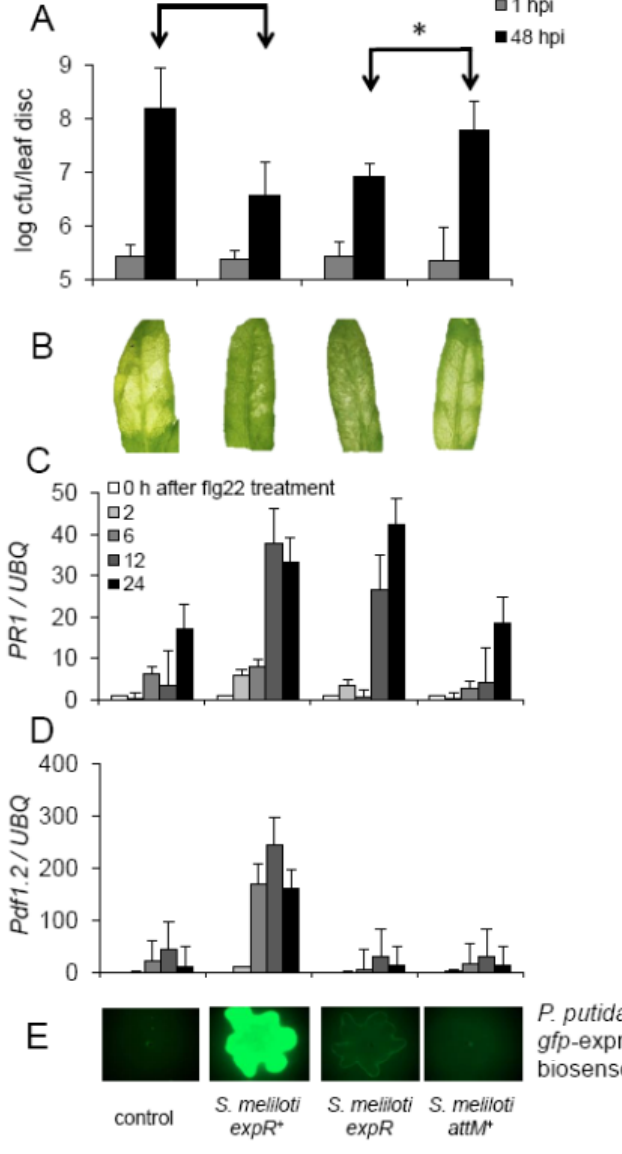
Figure 4. The S. meliloti strains producing oxo-C14-HSL enhance resistance in Arabidopsis plants. The enhancement in resistance towards the pathogenic bacteria in Arabidopsis is dependent on AHL. ( A ) Proliferation of the plant-pathogenic P. syringae DC3000 ( Pst ) on plants pretreated with MgCl (control) or different S. meliloti strains, 2 producing different quantities of oxo-C14-HSL. *** p > 0.0005; * p > 0.05 in Student’s t -test. cfu; colony forming unit ( B ) Symptoms caused by infiltration with Pst bacteria into Arabidopsis leaves; ( C ) and ( D ) Expression of the defense related Pathogenicity Related 1 ( PR1 ) ( C ) and Pdf1 . 2 ( D ) genes. Expression was normalized to the expression of the At5g25760 gene ( UBQ) . Total RNA was extracted from 2-week-old Arabidopsis seedlings pre-treated for 3 days with AHL extract from different S. meliloti cultures and challenged with 100 nM flg22 for hours as indicated. Graphs present a representative experiment from three independent replicates; ( E ) AHL production in S. meliloti strains used in the above experiments detected by the bacterial biosensor strain P. putida